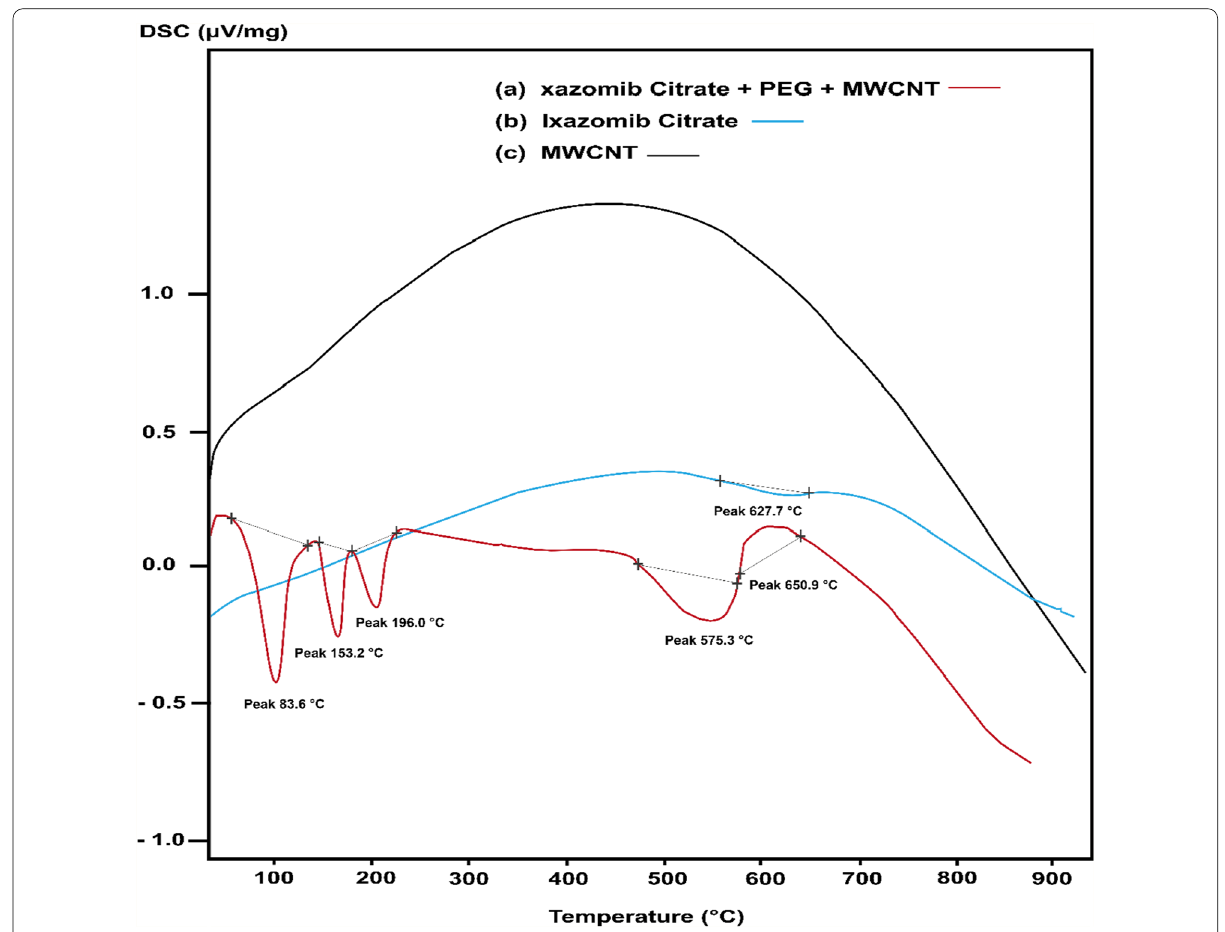
Fig. 8 The DSC curve of Ixazomib citrate, MWCNT, and the composite (MWCNT@PEG@Ixazomib)